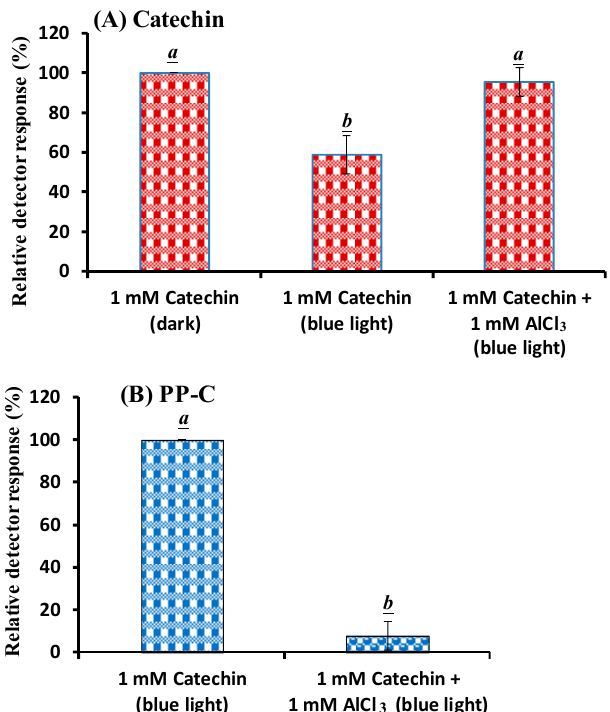
Figure 6. The relative components of ( A ) catechin and ( B ) proanthocyanidin remaining after 1 mM catechin was treated with or without 1 mM AlCl 3 under BLI at 20 W / m 2 for 120 min. PP-C: The photoreaction product from the catechin. Statistical di ff erences between groups are denoted by di ff erent letters (a and b) above each bar. The level set for statistical significance was p -value < 0.05.